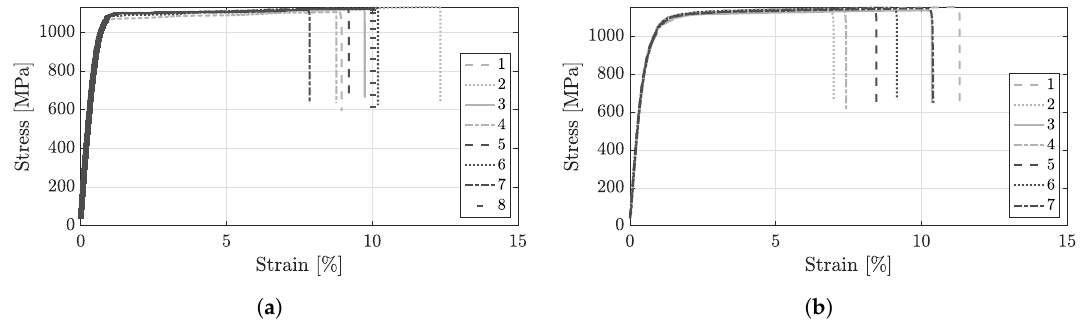
Figure 1. Stress over strain resulting from tensile tests to determine the Young’s modulus of cold rolled 1.4310 stainless steel. ( a ) Stress–strain curve in direction of rolling (DOR); ( b ) Stress–strain curve transverse to